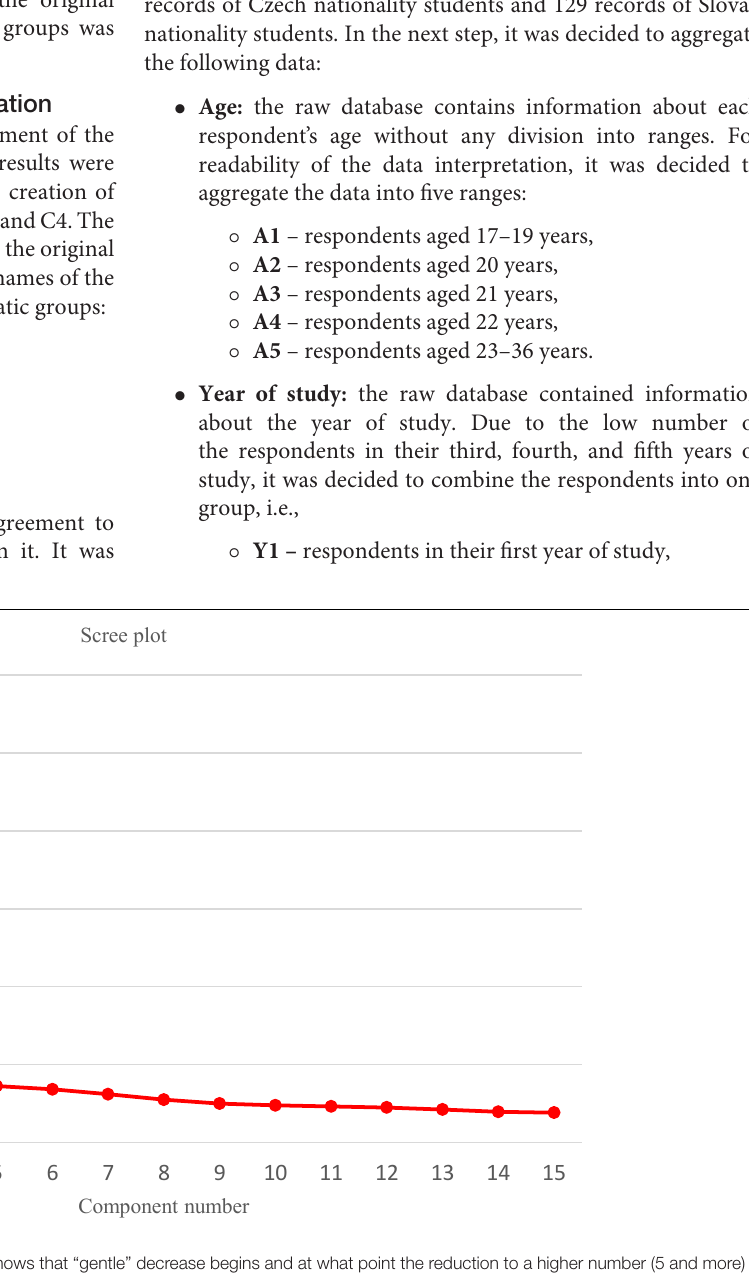
Frontiers in Psychology |